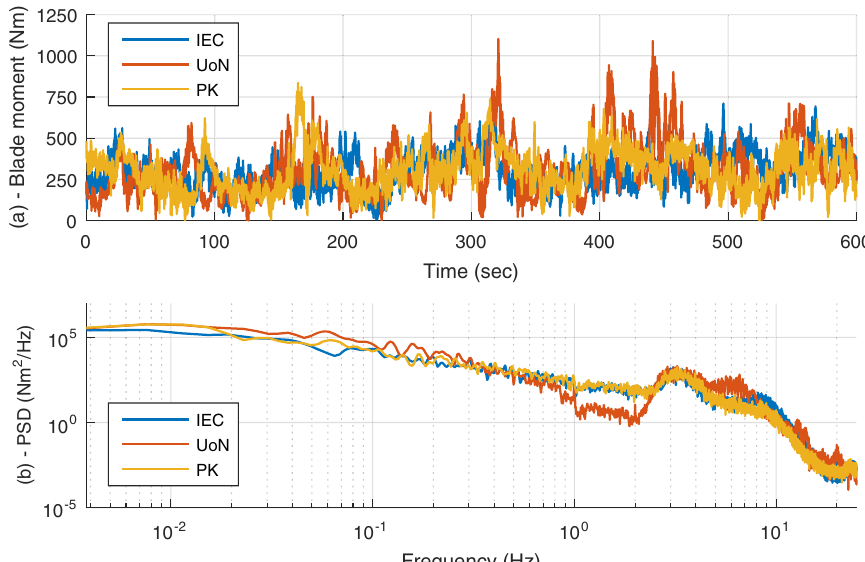
Fig. 3. Time series plot (a), and power spectral density plot (b), of blade fl apwise